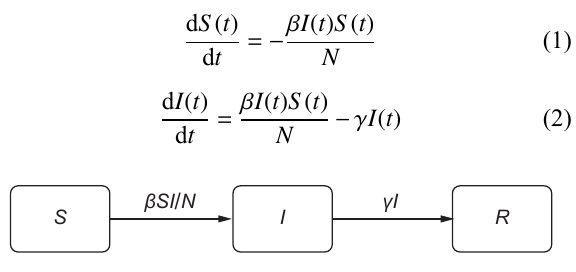
Fig. 1 Transfer diagram of the SIR